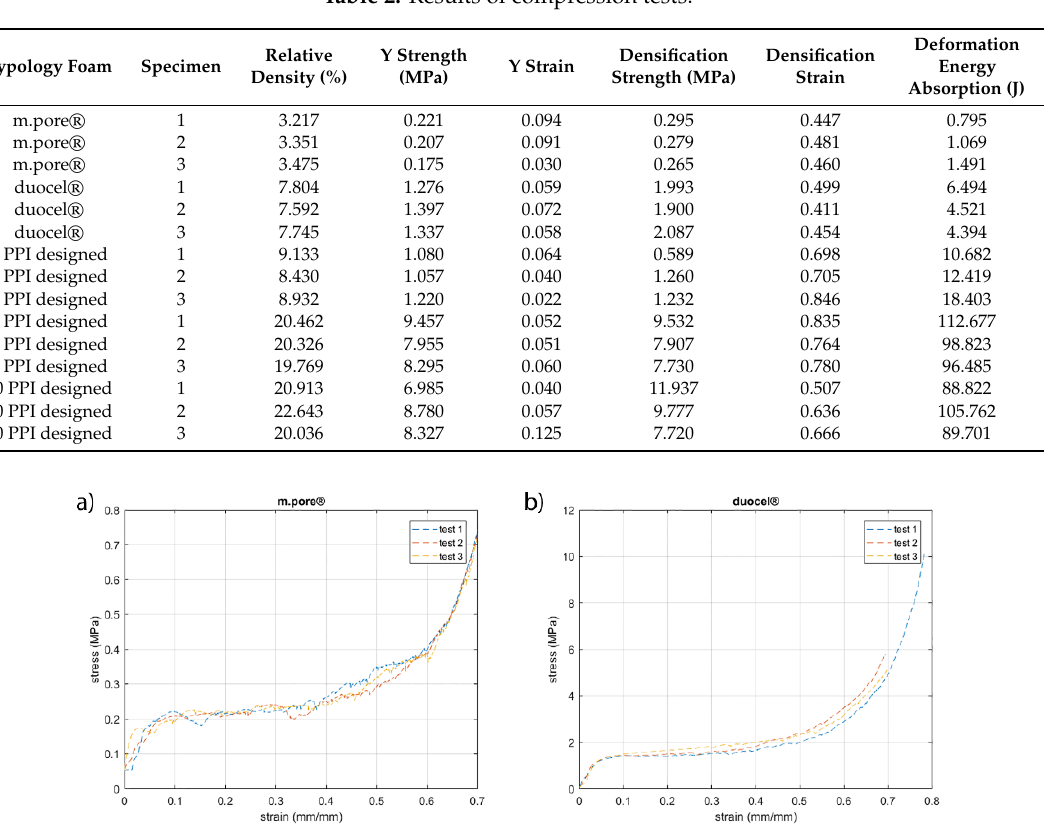
Table 2. Results of compression tests.